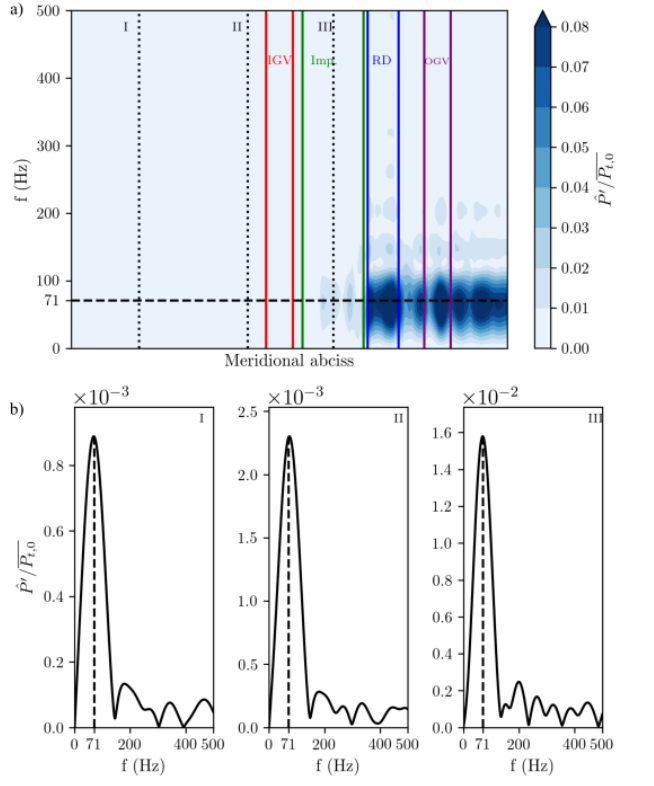
Figure 17. Frequency content of static pressure fluctuations at the shroud during an MS period at